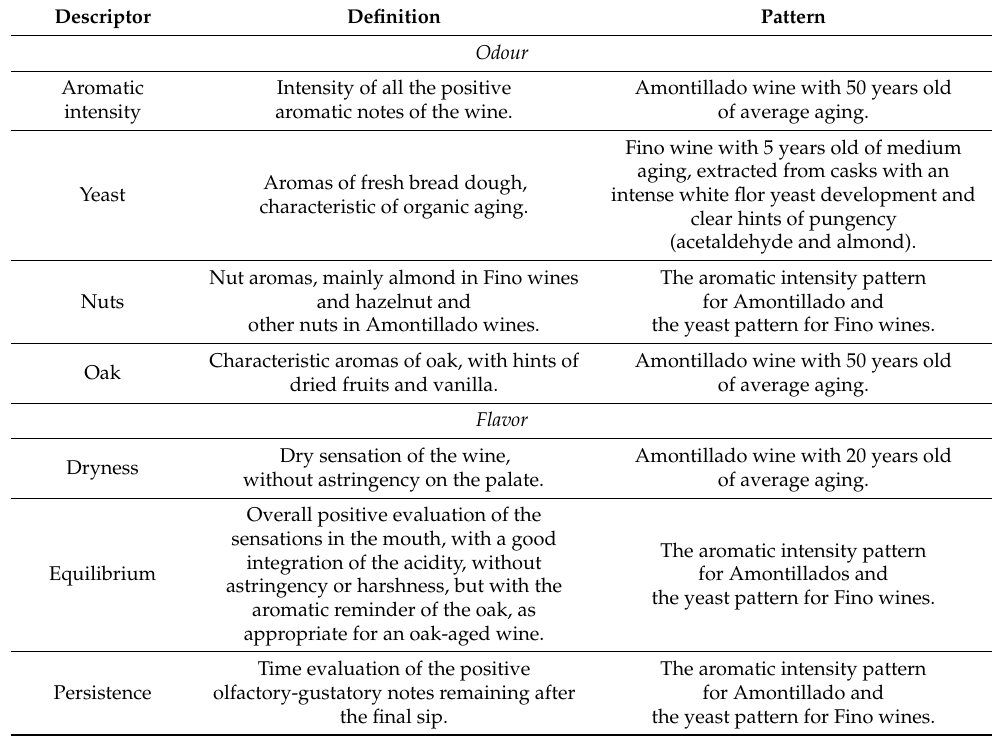
Table 1. Nose and mouth descriptors and patterns used during the work with the